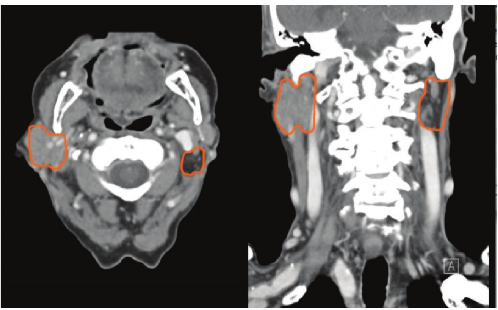
Figure 4: Head and neck CT scan (axial and coronal views) made 4 years after the left parotidectomy, showing a moderate partial atrophy of the autologous fat graft.